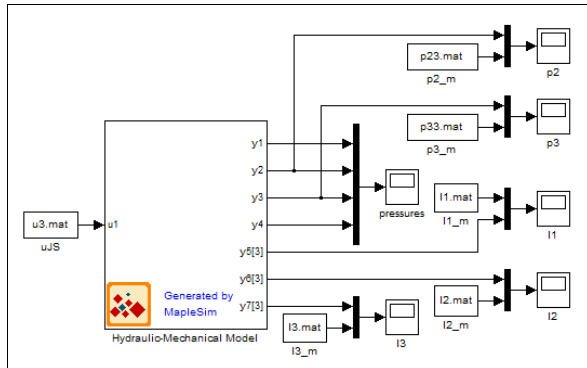
Figure 13: Simulink model of the